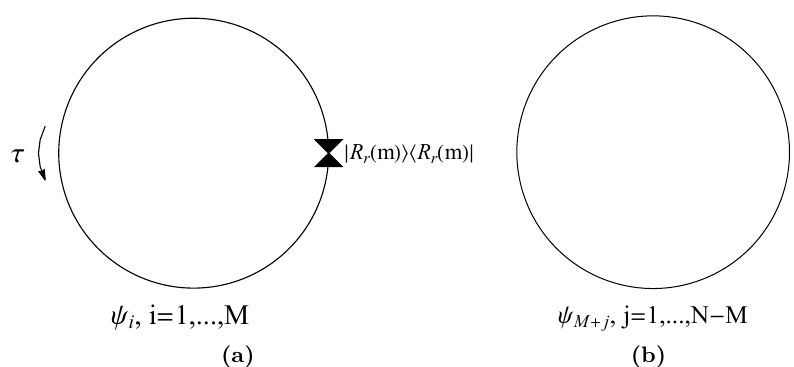
Figure 2. Different boundary conditions for Majorana fields in the imaginary time contour. (a) The measurement operator | R r ( m ) ih R r ( m ) | is inserted on the contour at τ = 0 , which is indicated by two small triangles, for ψ i , i = 1 , . . . , M . (b) The conventional contour for ψ j + M , j = 1 , . . . , N − M